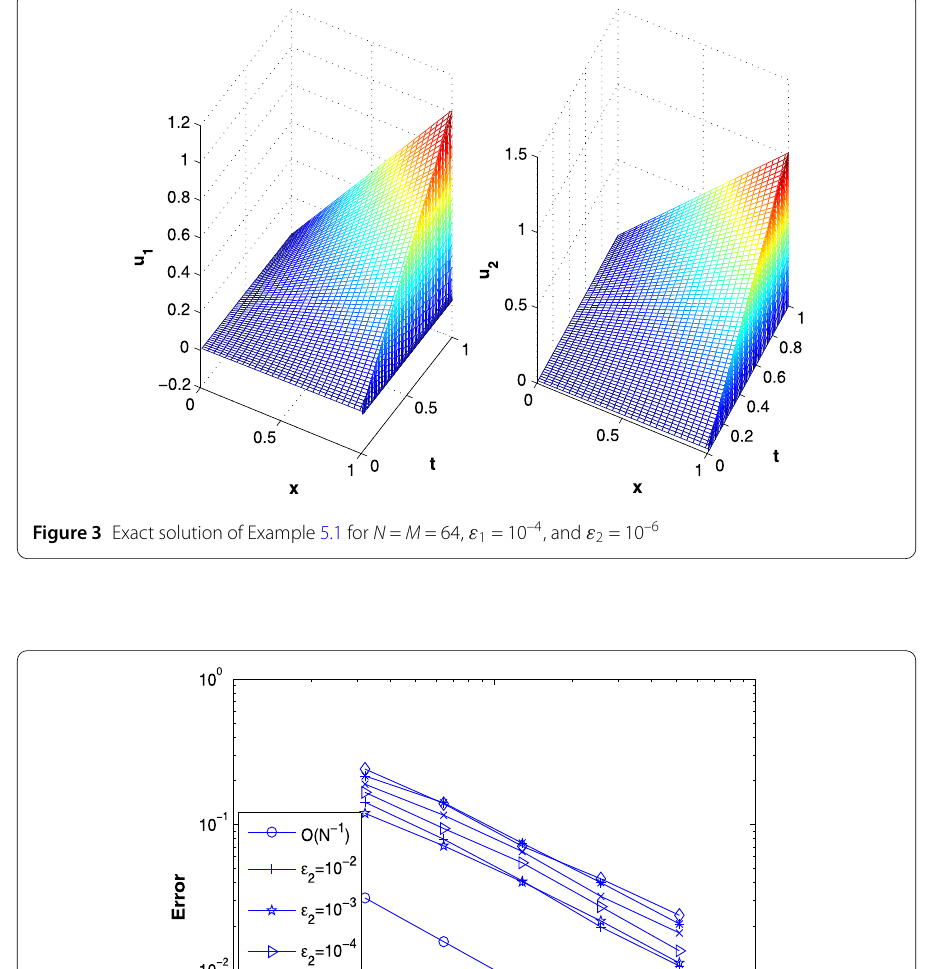
Table 5 Comparison of numerical results of Example 5.1 with Shishkin mesh with ε 2 = 10 –2